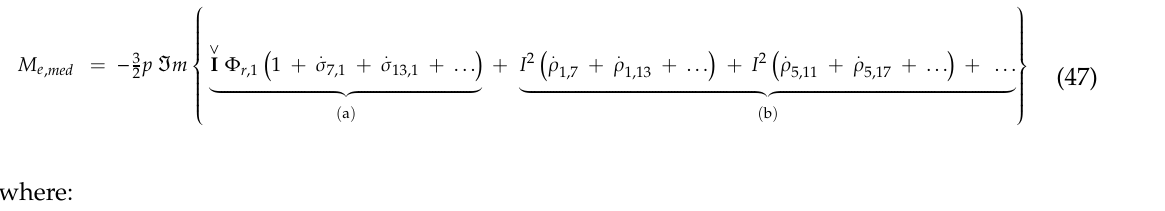
Figure 10. Comparison between no-load induced voltage in case of symmetric rotor (green line) and eccentric rotor (blue line).